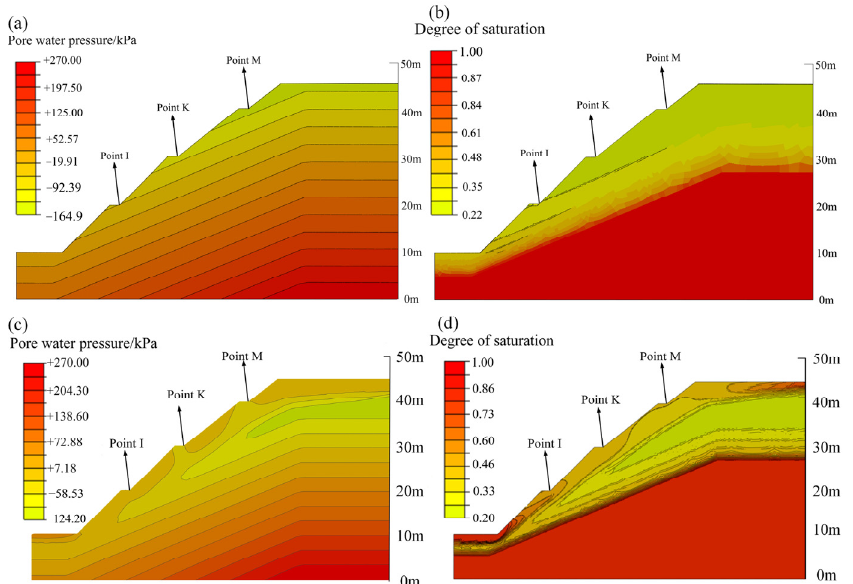
Figure 10. Contour maps of infiltration characteristics of the slope without protection: ( a ) pore water pressure before rainfall; ( b ) degree of saturation before rainfall; ( c ) pore water pressure after rainfall; ( d ) degree of saturation after rainfall.